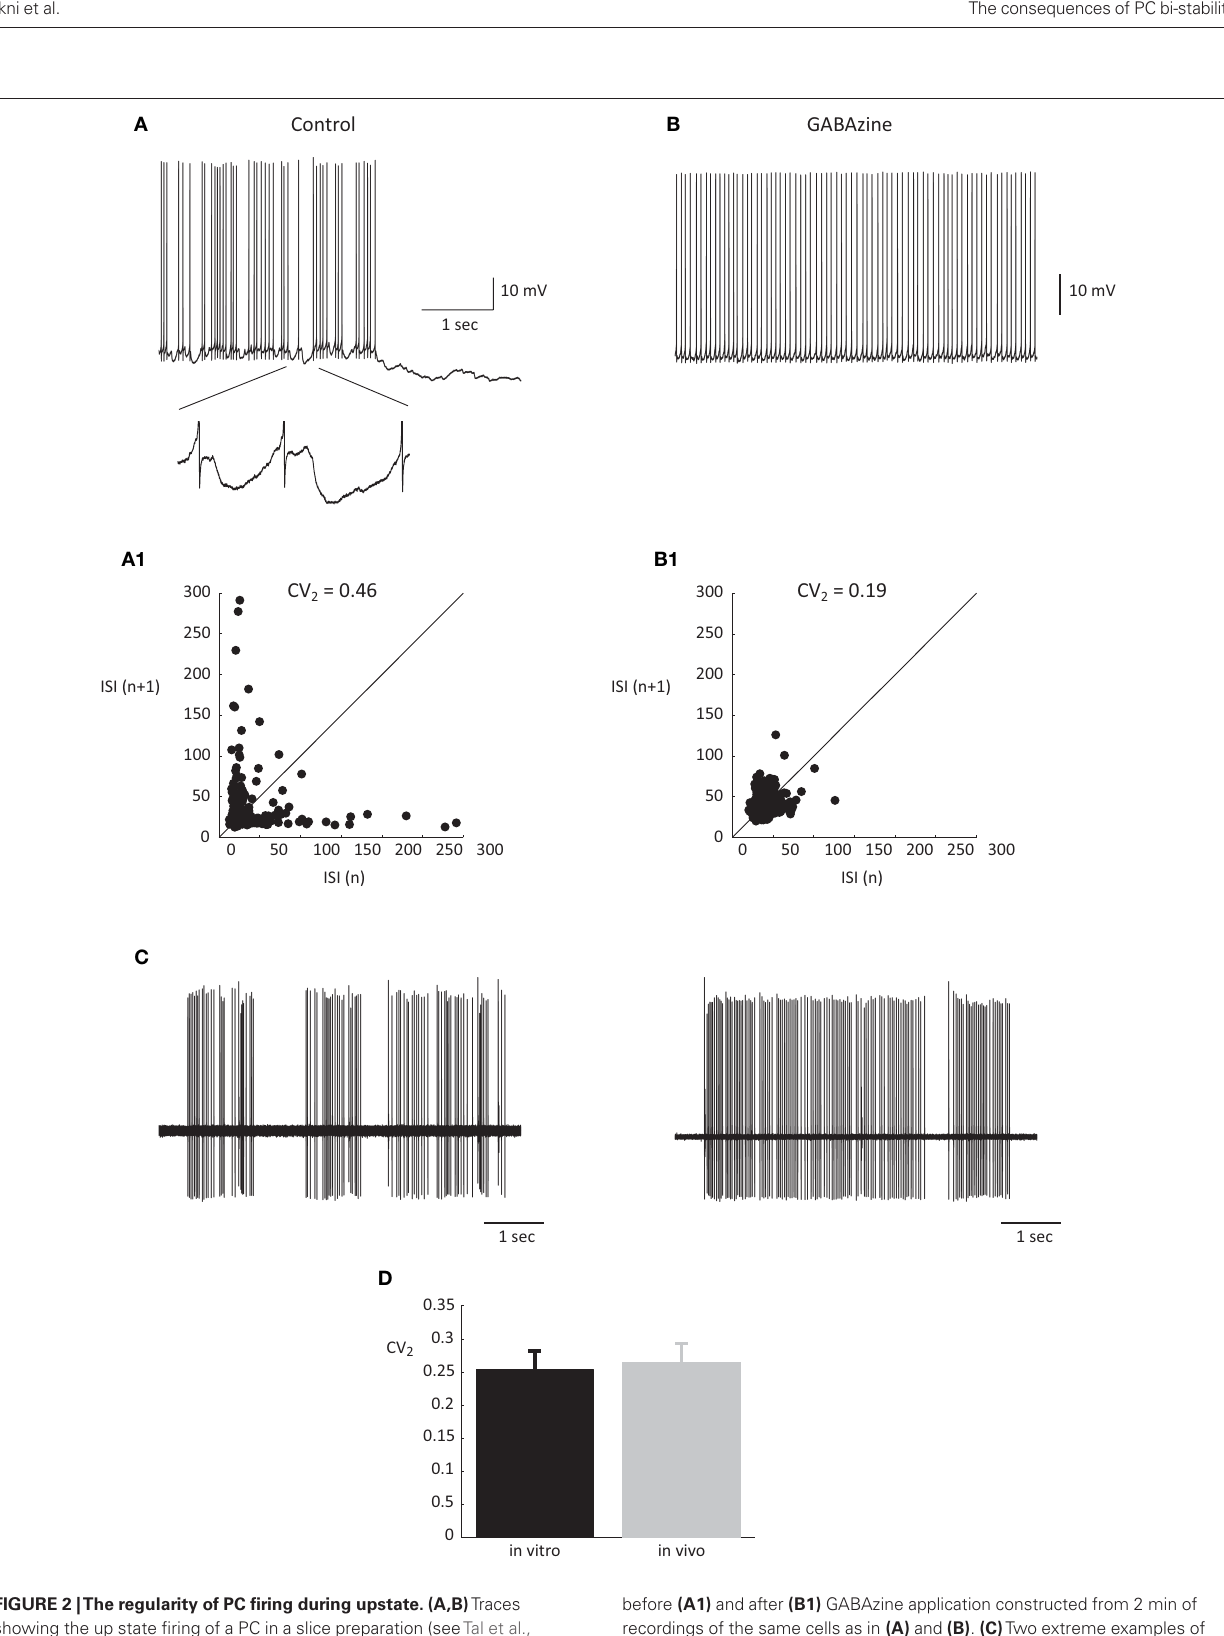
values obtained 2